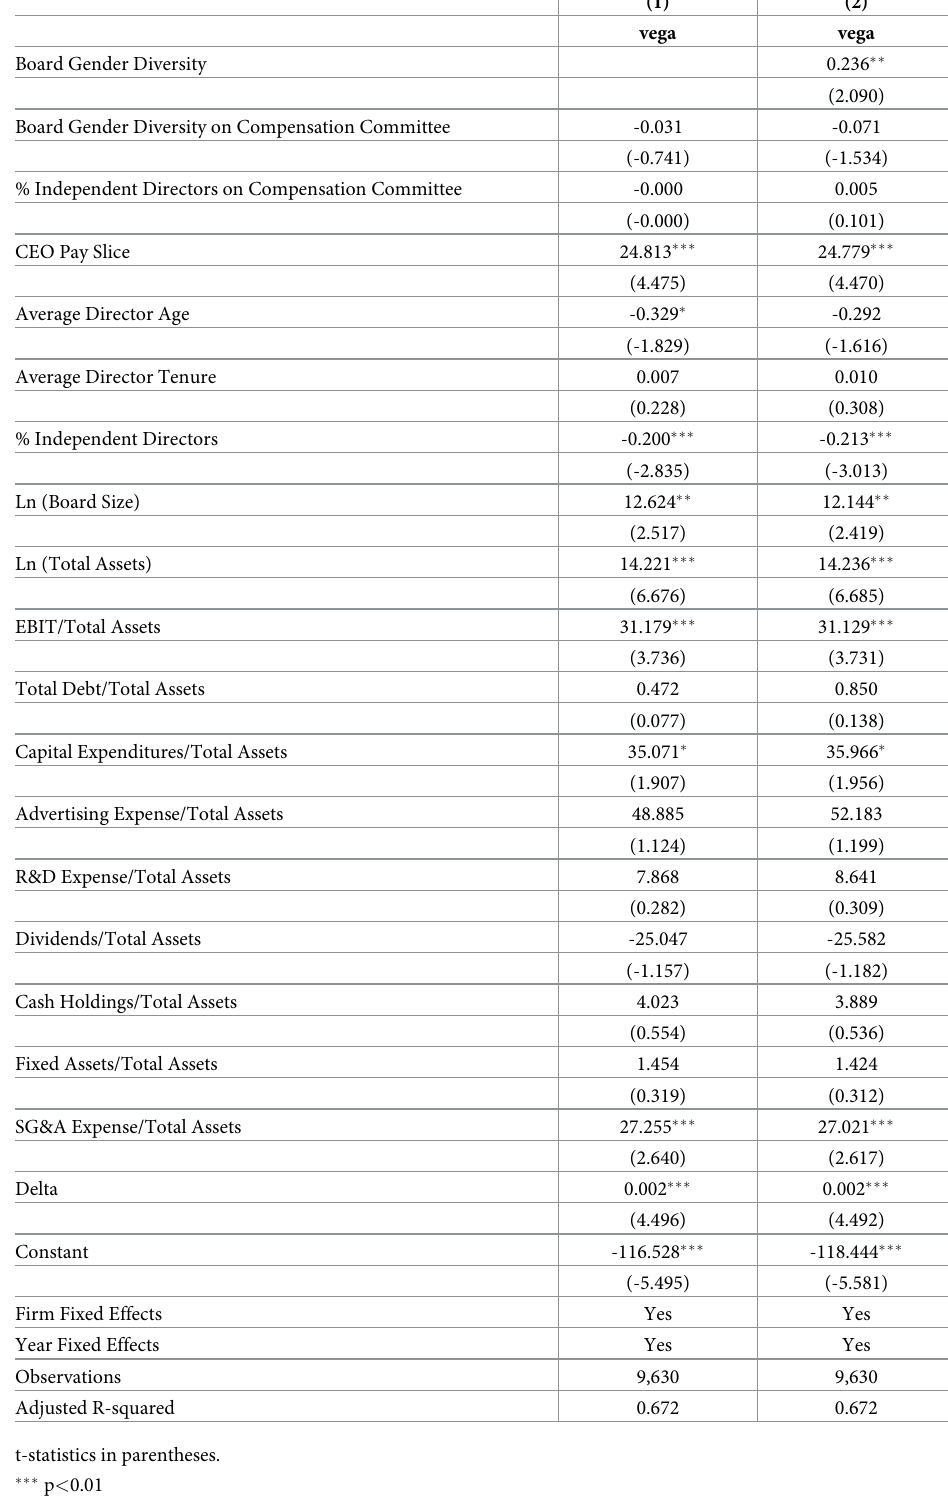
Table 7. The role of board gender diversity on the compensation